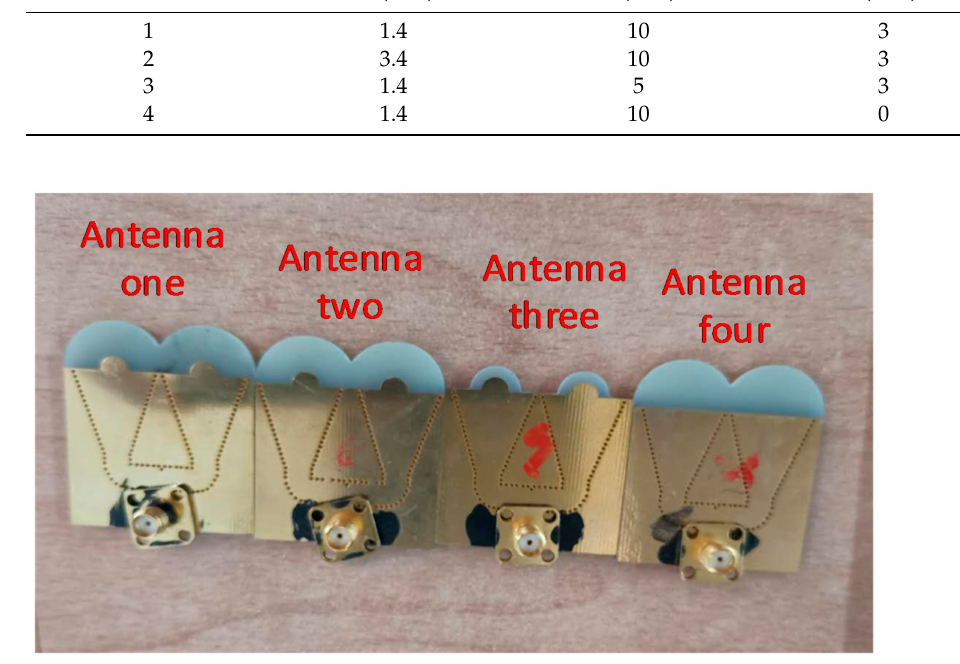
Figure 11. Comparison of four